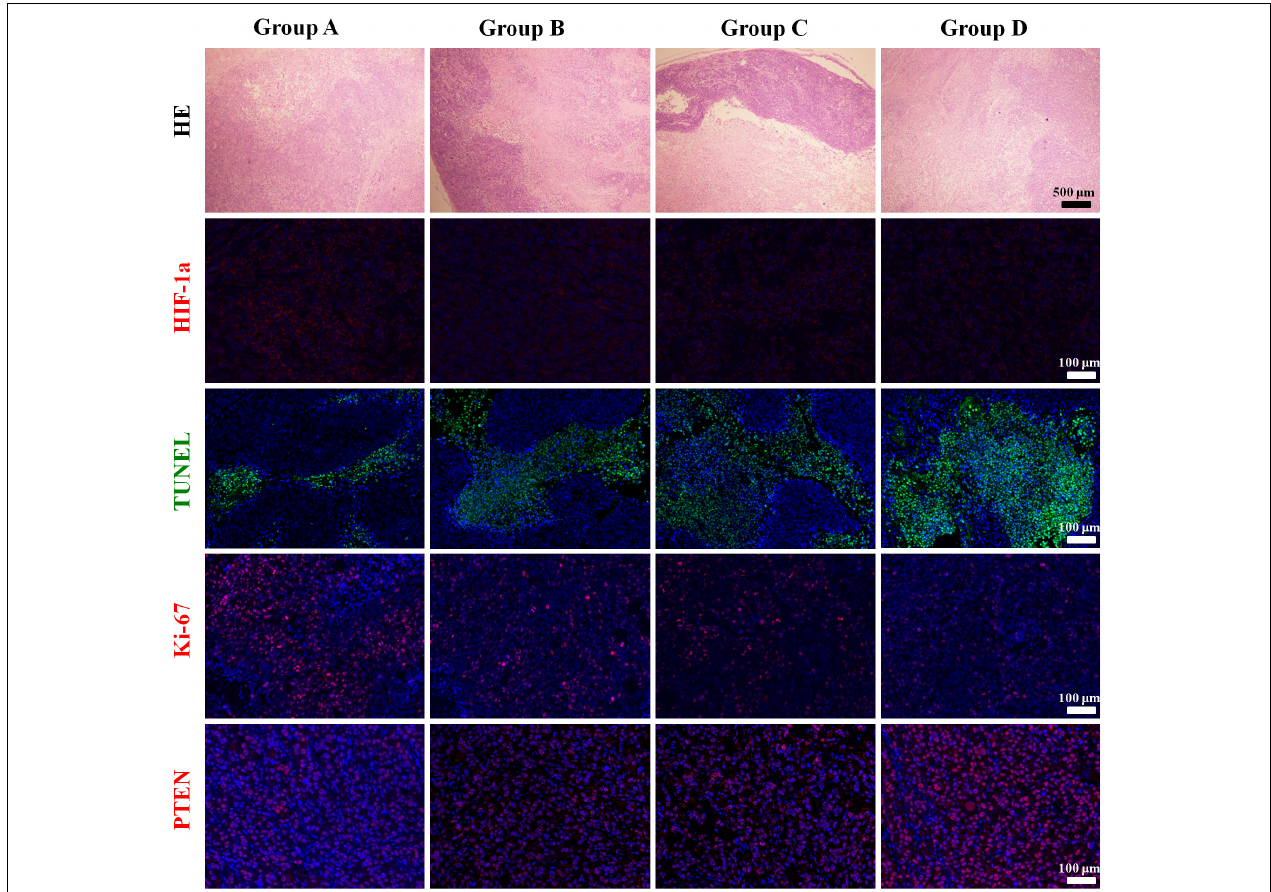
FIGURE 8 | The representative HE, HIF-1 α , Ki-67, TUNEL, and PTEN staining in Group A, B, C, and D at the last time point.